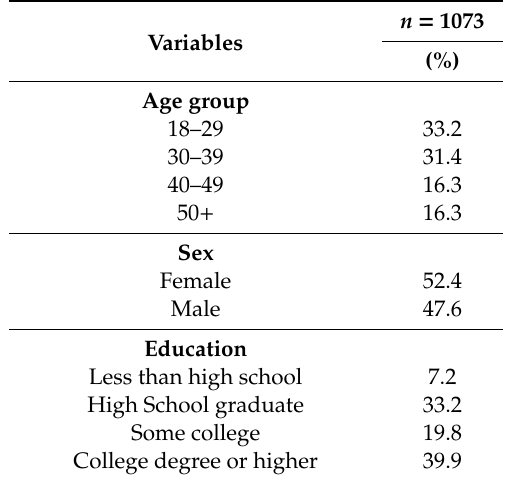
Table 1. Sample characteristics of smokers and vapers having health professional (HP) consultations during the prior 4 months, aged 18 to 71, and living in Mexico